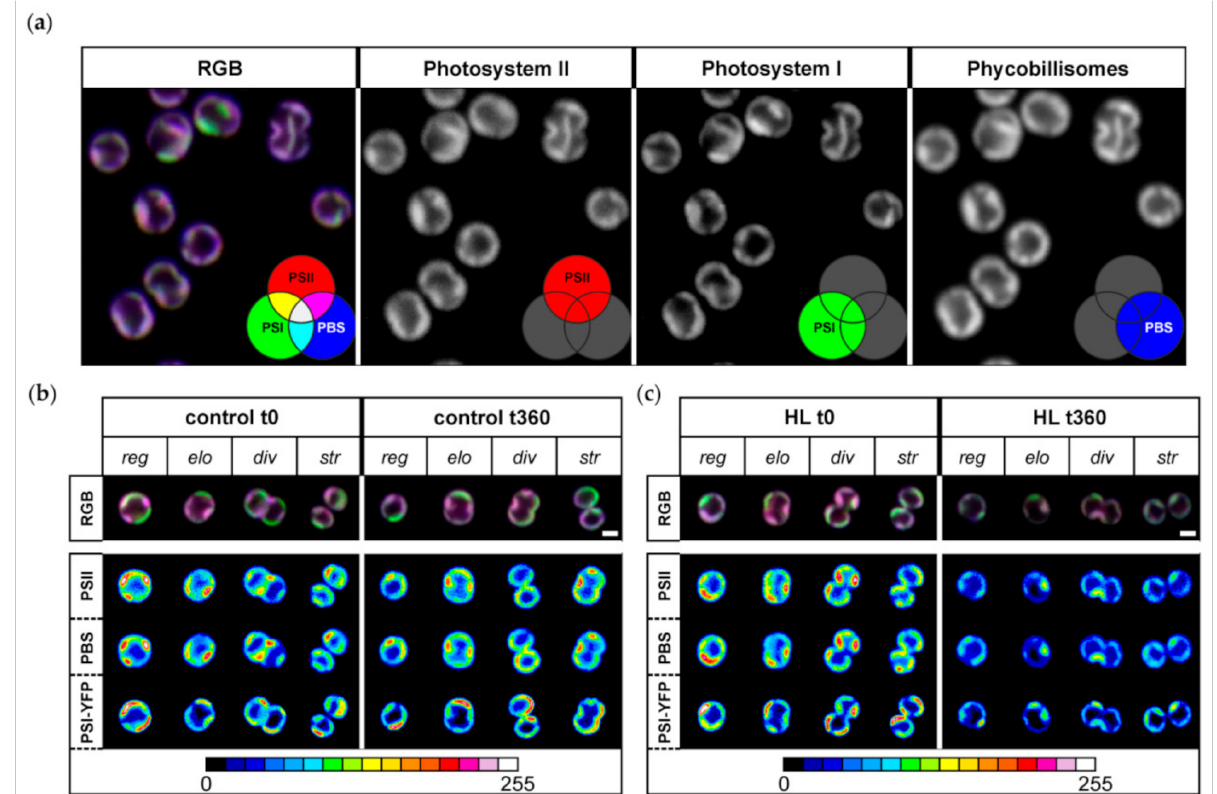
Figure 2. Microdomain (MD) organization of thylakoid membrane in Synechocystis PSI - YFP during HL treatment. ( a ) Typical RGB picture of Synechocystis PSI - YFP cells obtained by three channel confocal imaging (PSII channel—red; PSI–YFP channel—green; PBS channel—blue). Colors reflect PSI/PSII/PBS co-localization and the most dominant microdomains, namely magenta MD (dominant PBS and PSII, less PSI-YFP) and green (dominant PSI-YFP, less PSII and PBS) as described by Straškov á et al. 2019. Panels ( b ) and ( c ) represent change in MD organization in control ( b ) and HL treated cells ( c ) at the beginning (t = 0 min) and the end of the experiment (t = 360 min). The four typical cell shapes are presented independently (reg = regular, elo = elongated, div = dividing, str = string). The first row shows three channels’ pictures (RGB, 24-bit) with PSII, PBS, and PSI-YFP co-localization. The second, the third, and the fourth rows depict intensity of single-channel fluorescence of PSII, PBS, and PSI-YFP, respectively. Colors reflect intensity of fluorescence signal per channel (heatmap images) in the 8-bit scale 0–255 (see the color scale